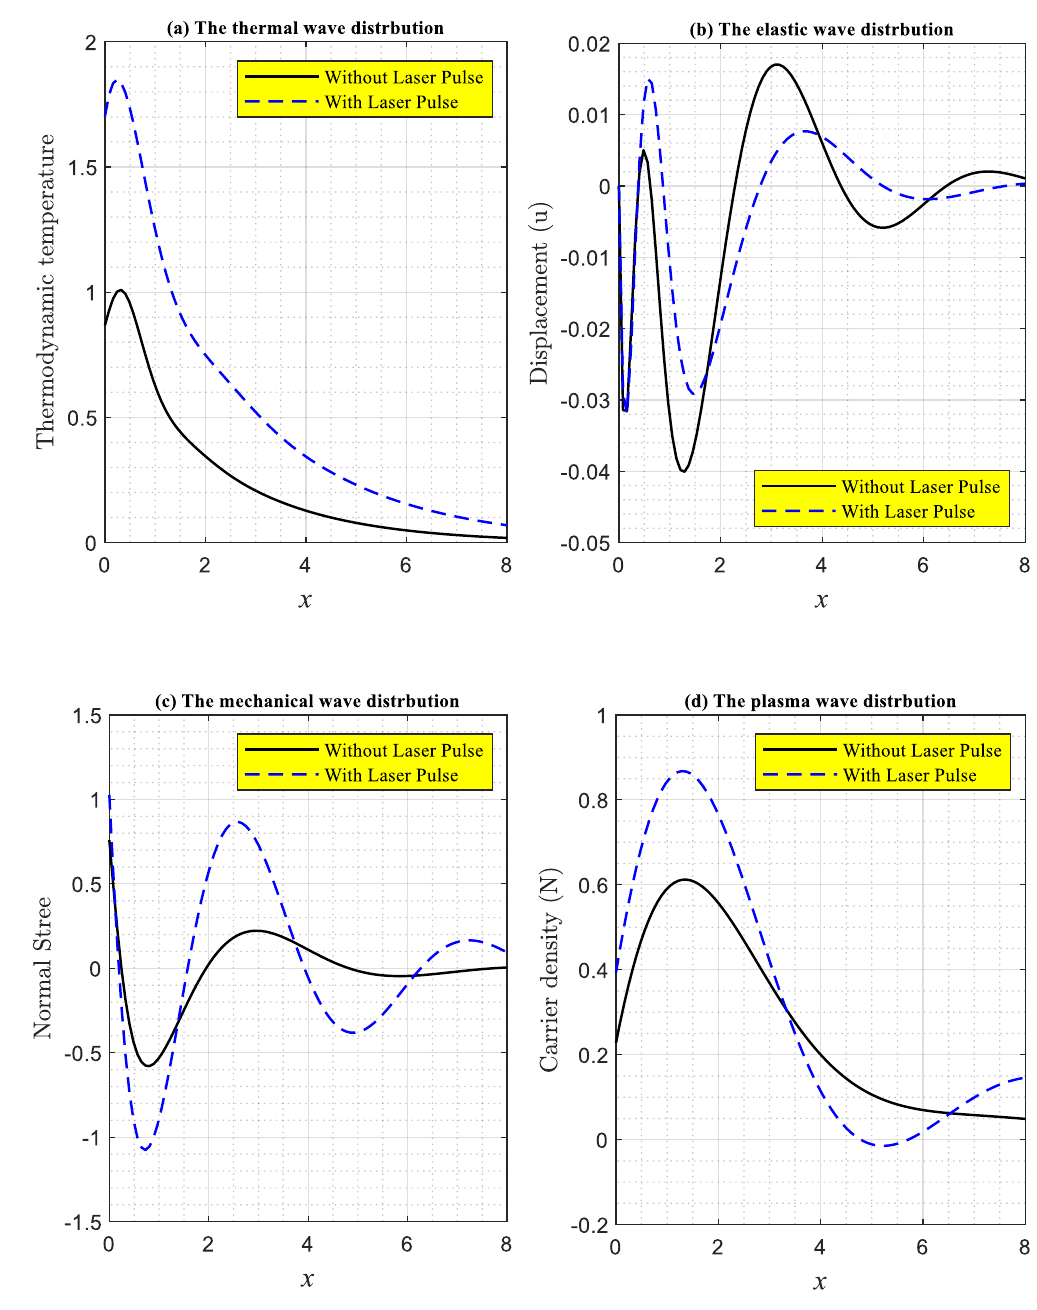
Figure 3. According to the DPL model, the main field distributions in two temperature fields under the impact of laser pulses and without them change with horizontal